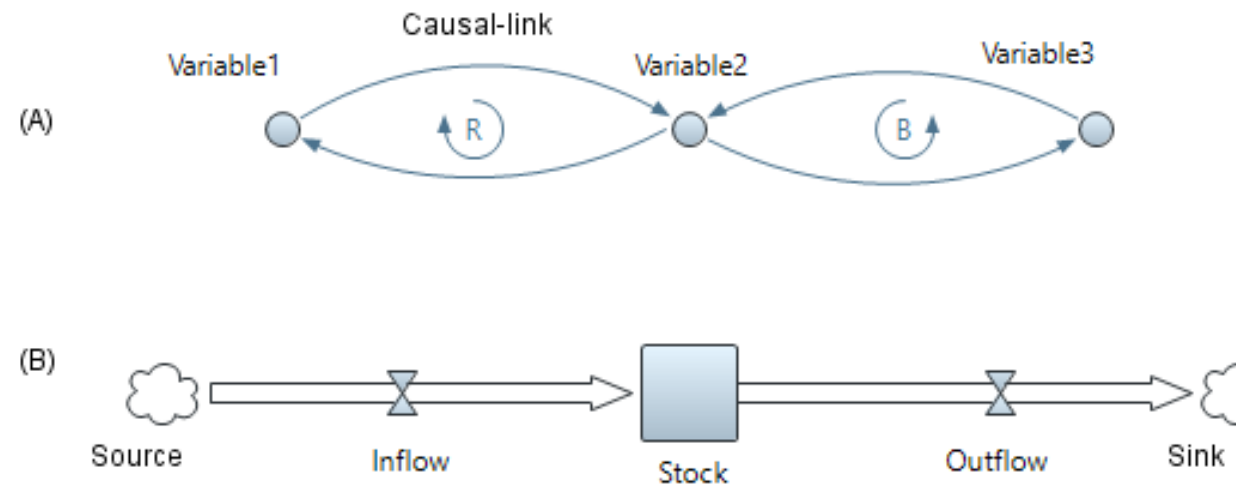
Figure 1. Components of system dynamics (SD): ( A ) Causal loop diagrams (CLDs) and ( B ) stock and flow diagrams (adapted from References [3,9]).